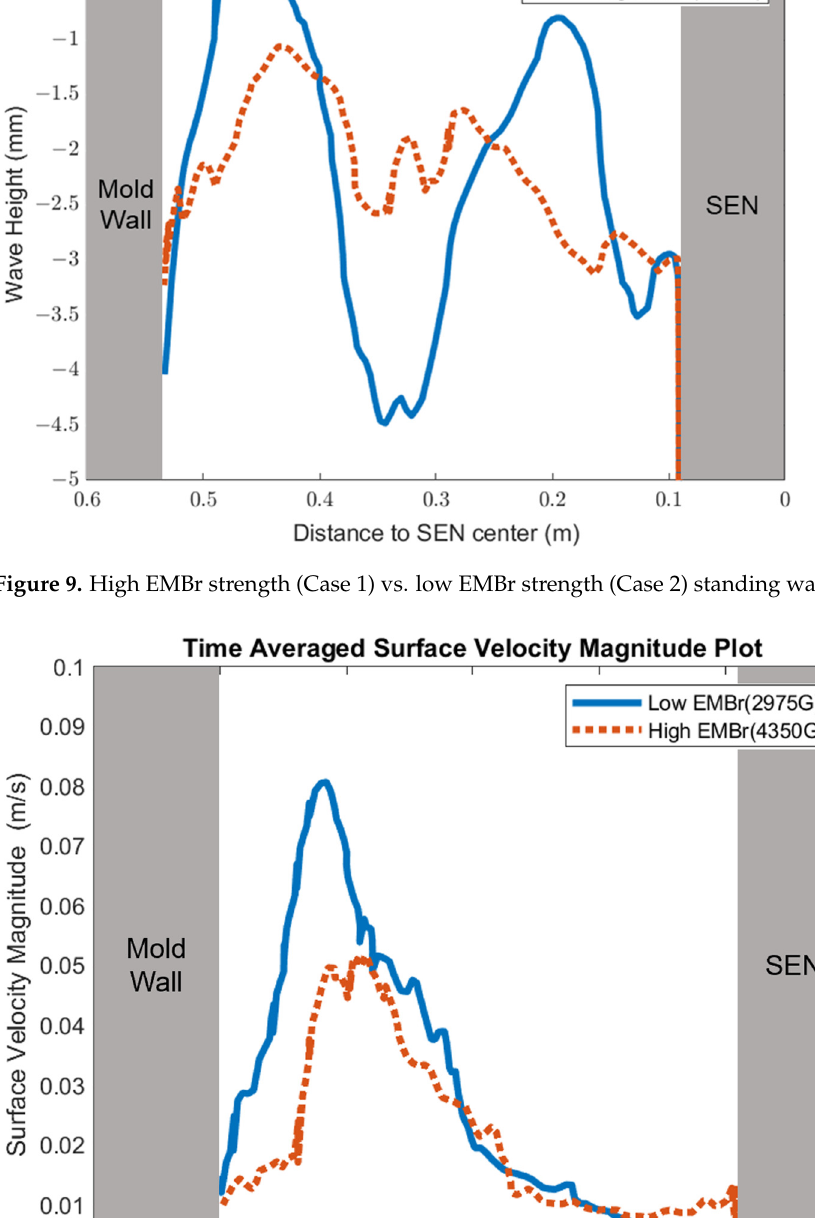
Figure 10. High EMBr strength (Case 1) vs. low EMBr strength (Case 2) standing velocity compari ‐ son.